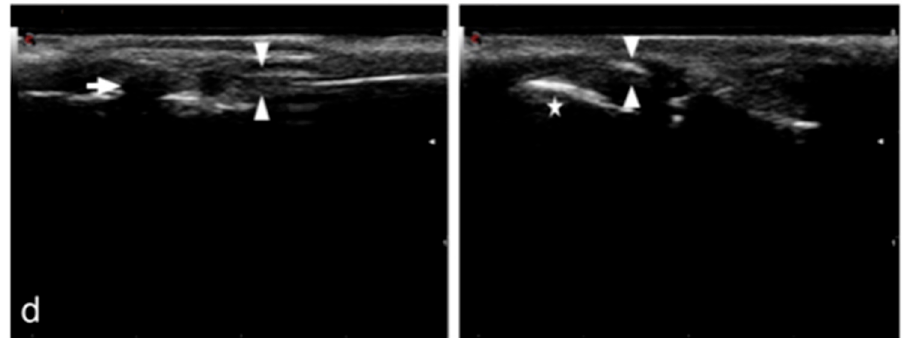
Figure 3. US assessment of the forepaws of the three patients compared with the normal US appear- ance. ( a ) Normal US anatomy, longitudinal scan: the CDET with its straight and well-defined fibrillar pattern is clearly visualized (between white arrowheads). The embedded sesamoid bone (white circle) is visible. No signs of effusion are present around the tendon. The MCP joint space (white star), the meta- carpal bone (right white asterisk), and the first phalangeal bone (left white asterisk) are clearly observed. Transverse scan: the CDET with the embedded sesamoid bones (white circles) is clear and well visual- ized. The two white asterisks indicate the underlying bone surfaces of the first phalanx. ( b ) Case 1: longi- tudinal scan. Anechoic layer (white arrow) surrounding the CDET of digit IV; the CDET (between white arrowheads) appears grossly intact, although the fibrillar pattern is not well defined. Transverse scan: the CDET (between white arrowhead) of digit IV appears grossly intact without signs of displacement. ( c ) Case 2: longitudinal scan of digit IV. Anechoic layer (white arrow) surrounding the CDET of the digit; the CDET (between white arrowheads) of digit IV appears grossly intact. The sesamoid bone embedded in the tendon is clearly visualized. Transverse scan: the CDET (between white arrowheads) of digit IV appears grossly intact with the embedded sesamoid bone visible and with no signs of displacement. ( d ) Case 3: longitudinal scan. Anechoic layer (white arrow) surrounding the CDET of digit IV; the CDET (between white arrowheads) appears grossly intact. Transverse scan: the CDET (between white ar- rowheads) of digit IV (white star) appears displaced from its physiological position. Medial sublux- ation was suspected.